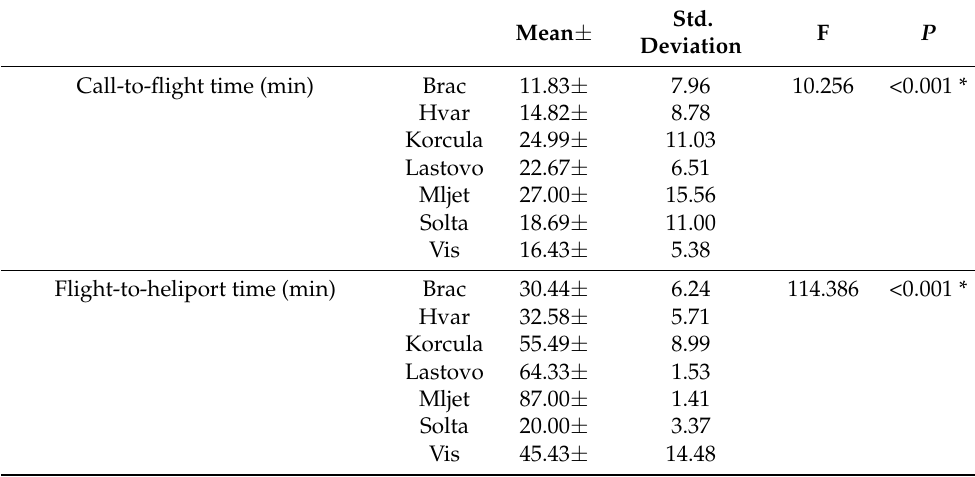
Table 3. Differences in transportation times between islands, one-way